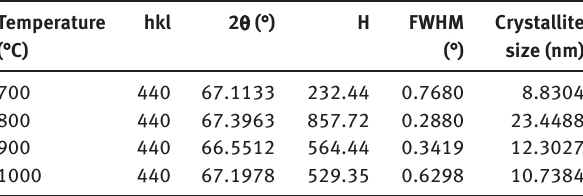
Figure 1: XRD patterns of the alumina products from the AlCl solution generated by the spray pyrolysis process.